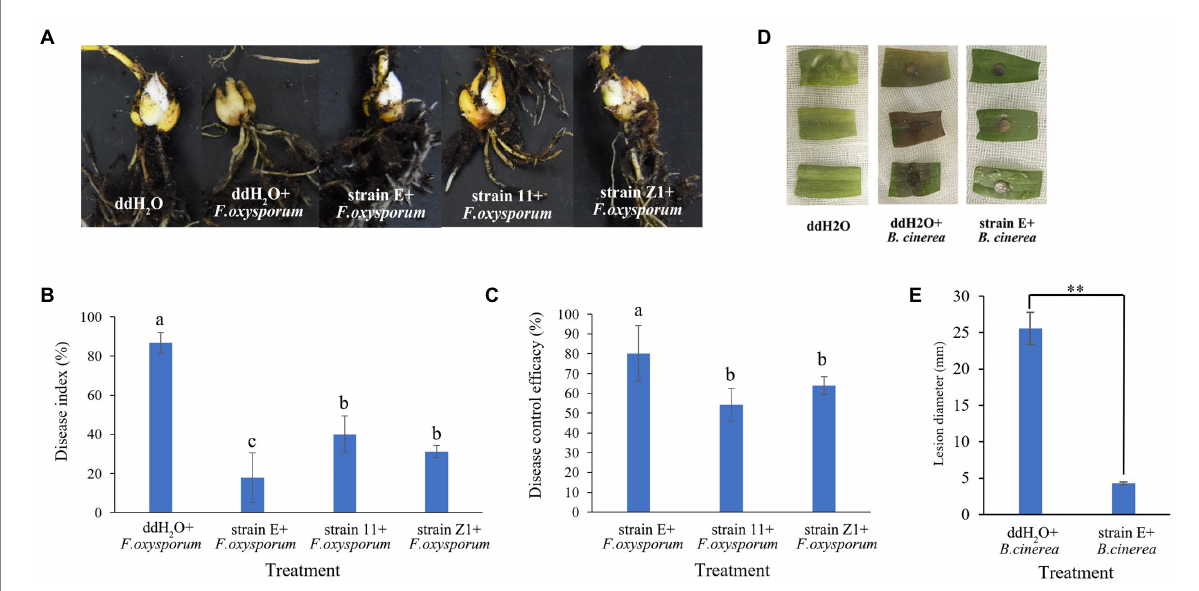
FIGURE 4 Efficacy of isolated bacterial strains in controlling lily basal rot and gray mold caused by F. oxysporum and B. cinerea, respectively. (A) Lily basal rot. (B) Lily gray mold. (C) Disease index and (D) control efficacy of bacterial strains against lily basal rot. Bars labeled with different letters are significantly different ( p < 0.05) according to Duncan’s multiple range test. (E) Lesion diameter of lily leaf after treatment with ddH 2 O and strain E. Asterisks indicate statistically significant difference according to Duncan’s multiple range test. ( ** p < 0.05).